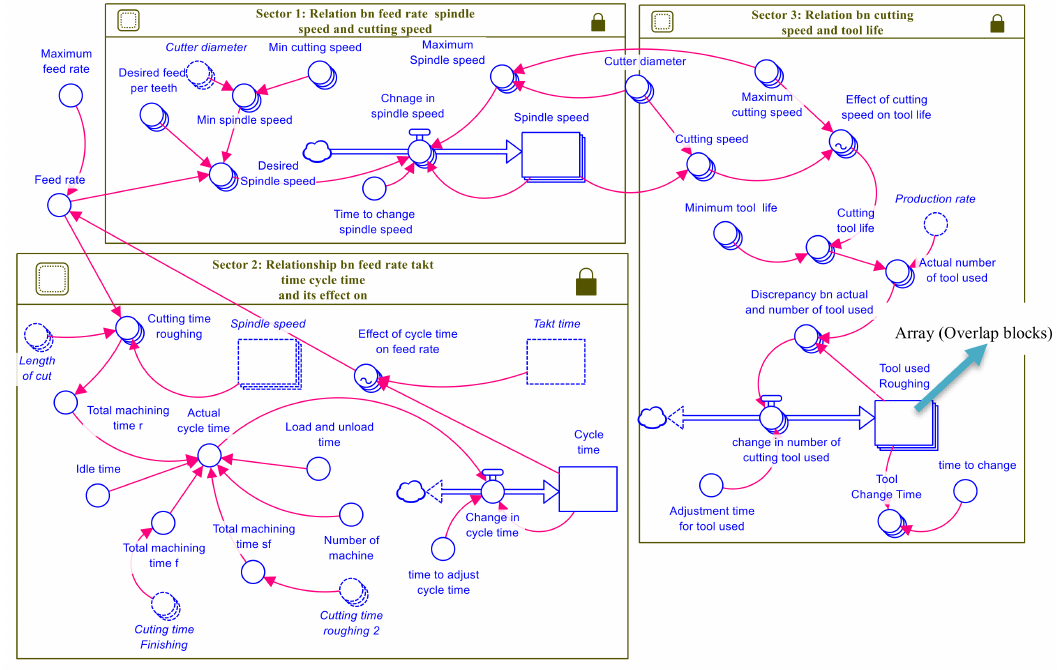
Figure 6. Machining process parameters